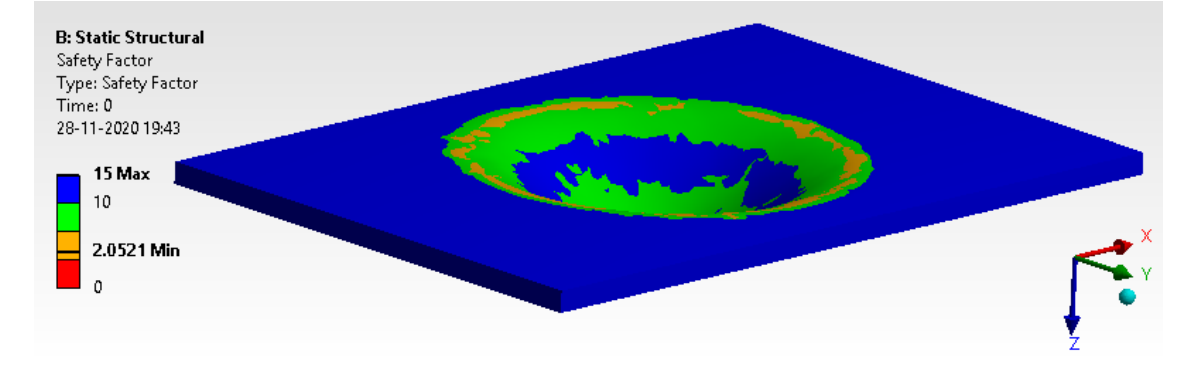
Figure 24. Factor of safety.